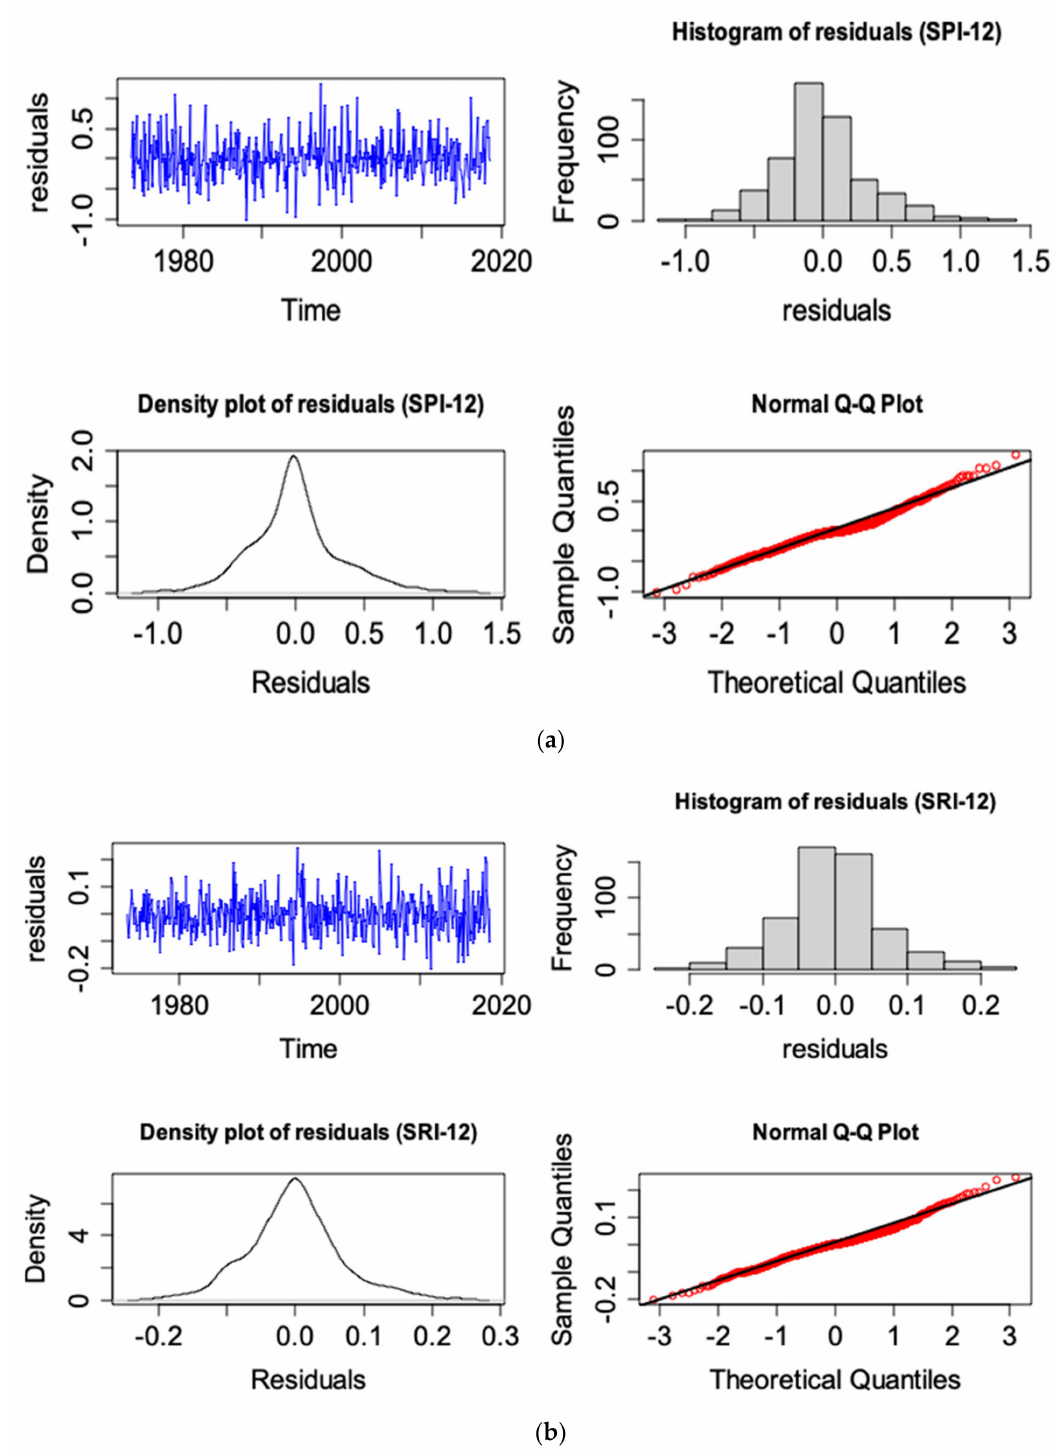
Figure 7. Normal probability plot and residual histogram for SPI-12 ( a ) and SRI-12 ( b